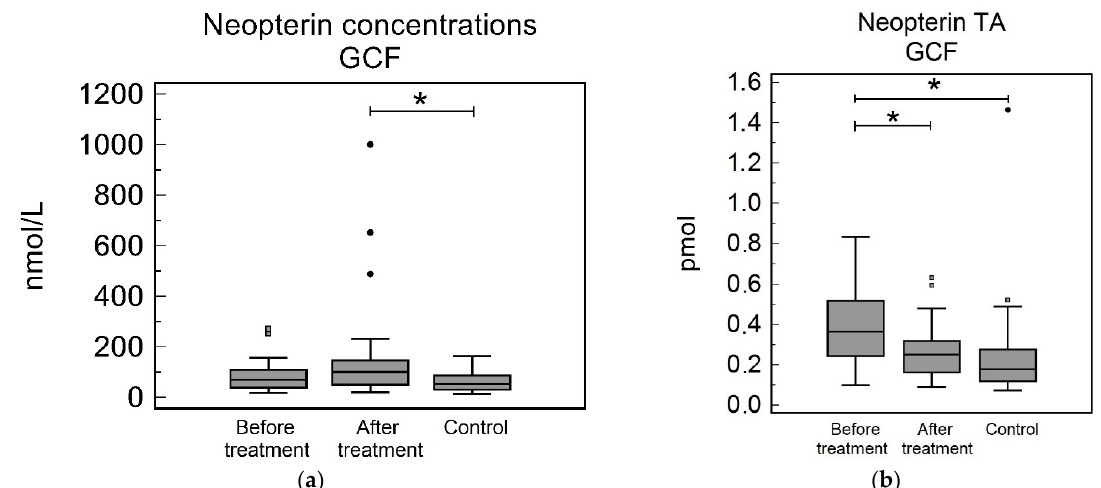
Figure 2. Neopterin in gingival crevicular fluid (GCF): ( a ) Neopterin concentrations ( b ) Neopterin total amount (TA). Neopterin concentrations in study group before treatment were not significantly different to after treatment concentrations ( p = 0.31) and to concentrations in control group ( p = 0.32). Neopterin concentrations in study group after periodontal treatment were found to be significantly higher after periodontal treatment to control group ( p = 0.038). Neopterin TA before treatment were significantly higher to after treatment levels ( p = 0.024) and to and to levels in control group ( p = 0.001). Neopterin TA after periodontal treatment were not significantly different to control group ( p = 0.11). * p < 0.05.